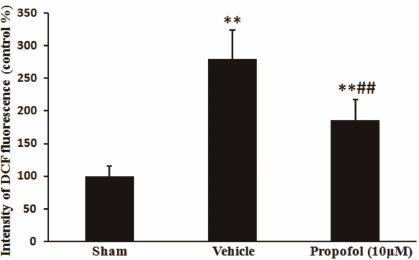
Figure 9. Effect of propofol on burn serum-induced reactive oxygen species (ROS) increase. Data are reported as % of sham values. Burn serum exposure significantly increased ROS level compared with the sham group. Propofol pretreatment inhibited the burn serum-induced increase of ROS. DCF: dichlorodihydro- fluorescein diacetate. Data are reported as means±SD (n=5 in each group). **P , 0.01, compared to the sham group; ## P , 0.01 compared to the vehicle group (one-way